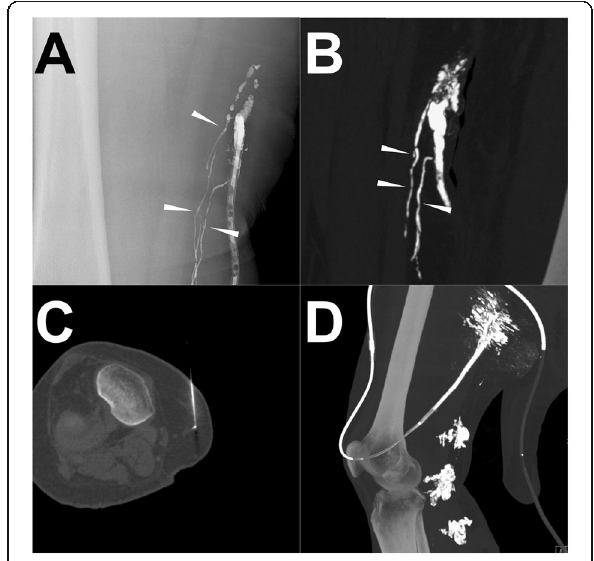
Fig. 6 A patient underwent ALVE procedure after post-LAG